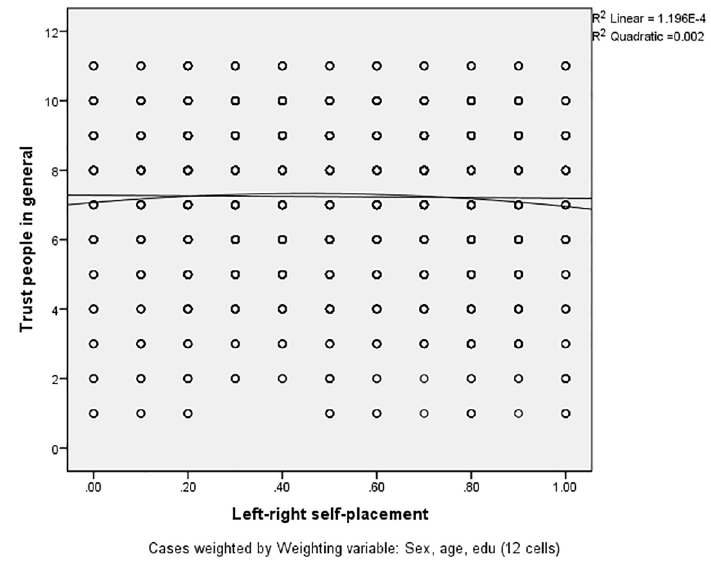
Figure 13. Linear and quadratic relationship between political ideology and interpersonal trust.